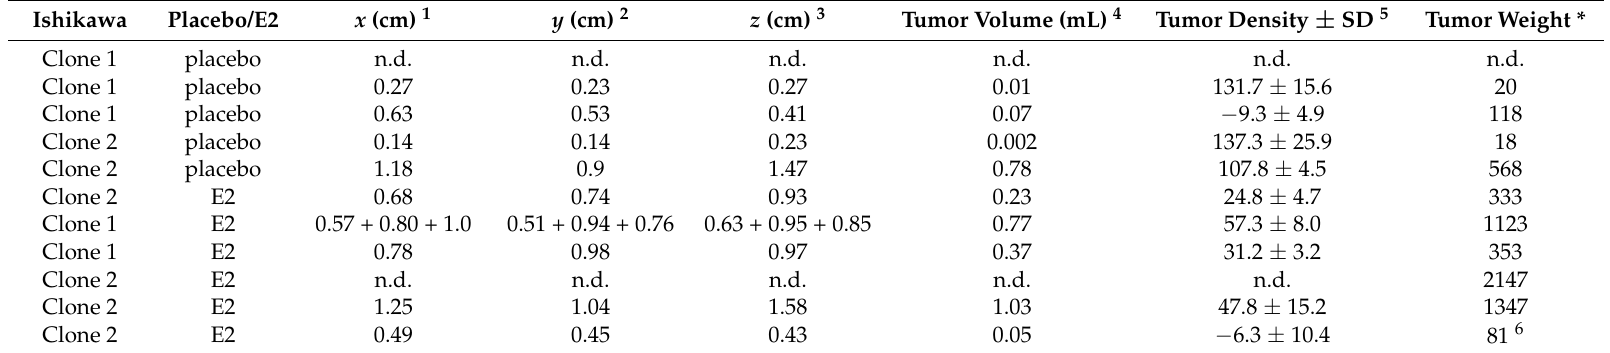
Table 3. Overview of the CE-CT scan